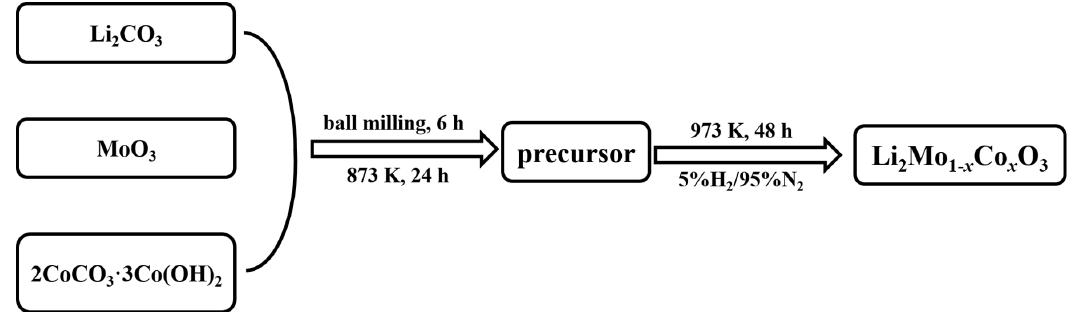
Figure 1. Flow chart of the process for preparing Li 2 Mo 1- x Co x O 3 .